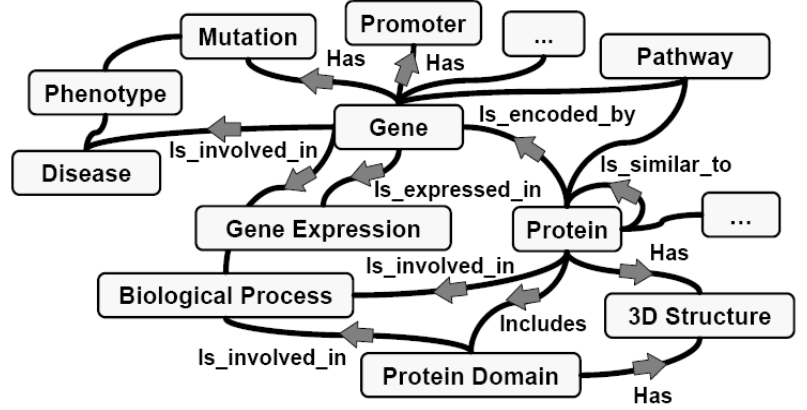
Figure 2: Biomedical Semantic Resource